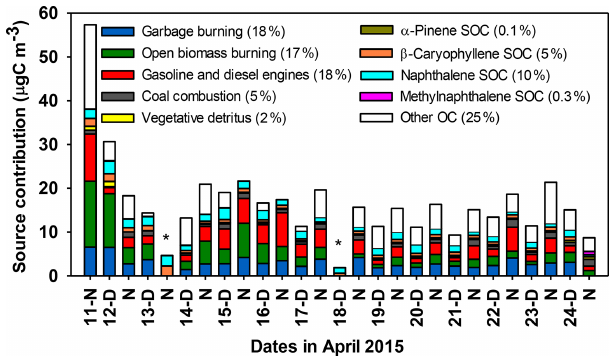
Figure 5. Apportionment of primary and secondary sources for PM 2 . 5 OC based on CMB modeling. Values in parentheses are av- erage percent contributions by the corresponding sources. Missing primary sources on 13-N and 18-D of April are marked with stars (see Sect.